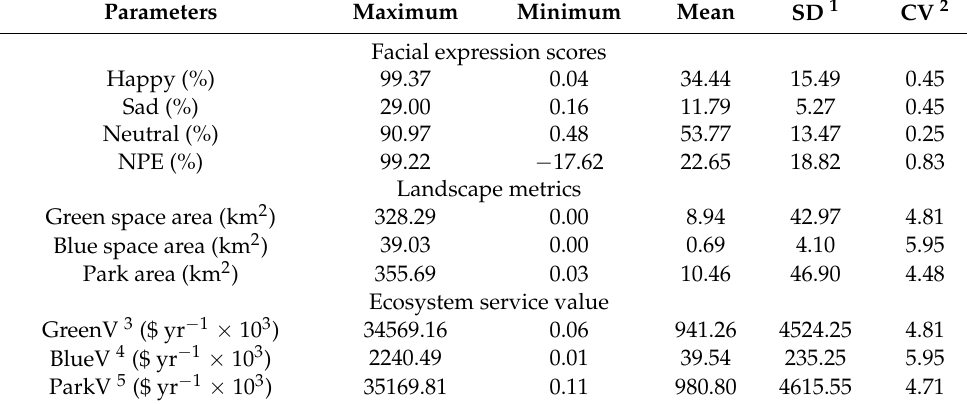
1 SD, standard deviation; 2 CV, coefficient of variance; 3 GreenV, value of cultural service in green space ecosystem; 4 BlueV, value of cultural service in blue space ecosystem; 5 ParkV, value of cultural service in ecosystems of green plus blue spaces in a